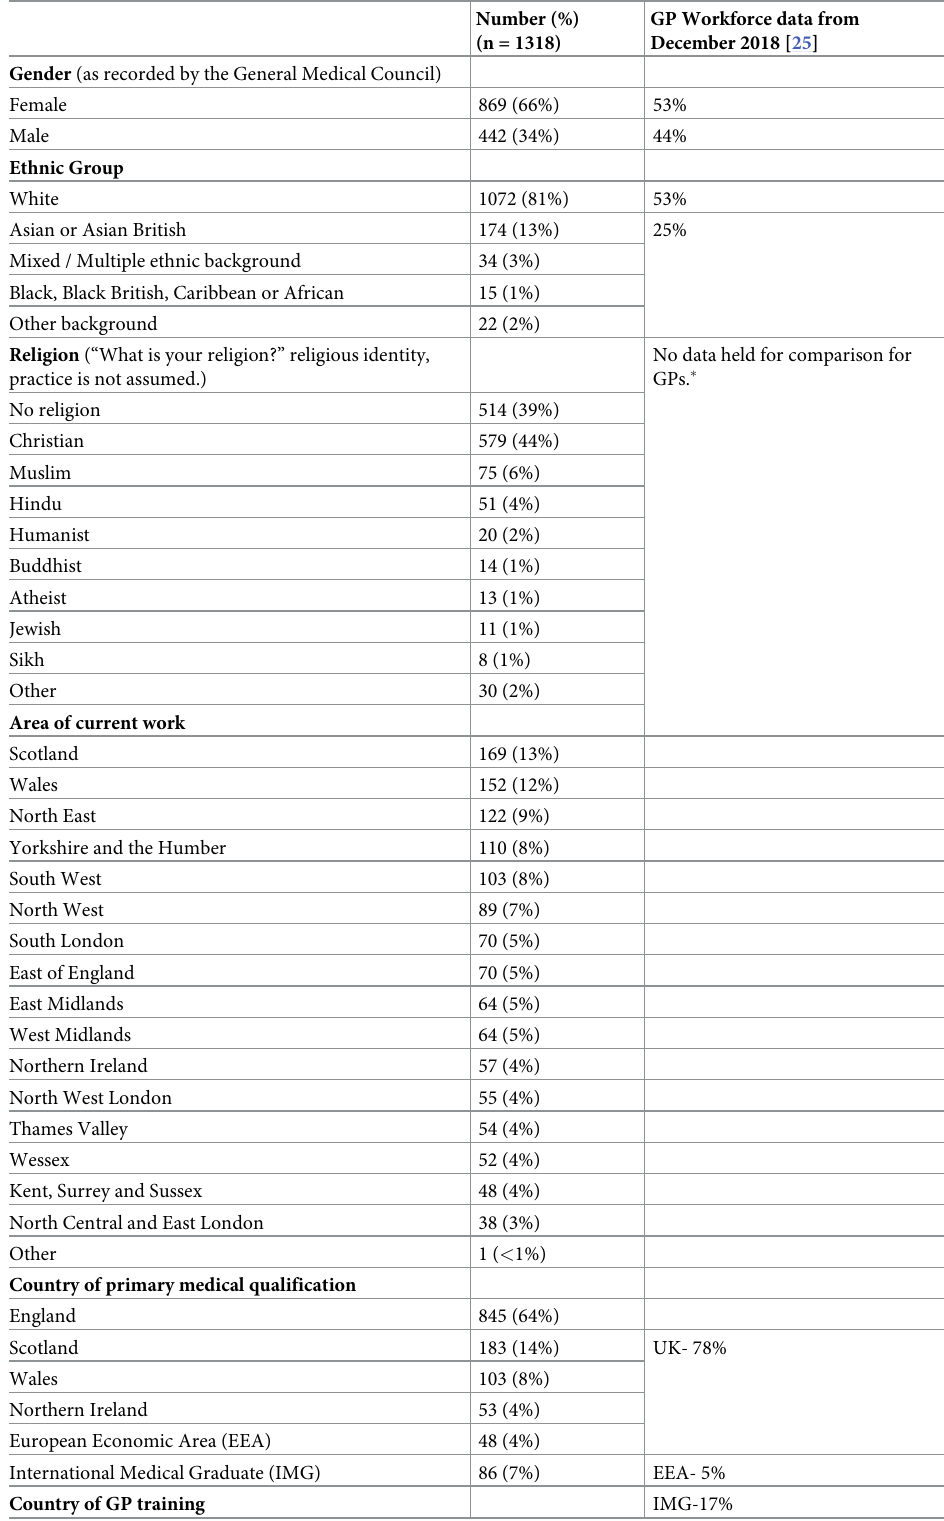
Table 1. Characteristics of